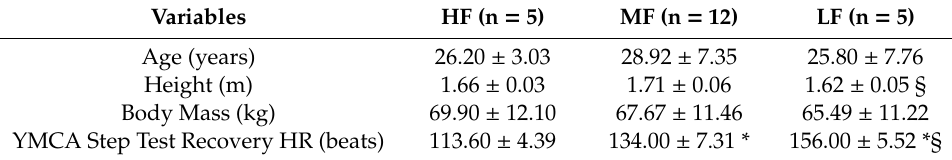
Table 2. Descriptive data (mean ± SD) for age, height, body mass, and recovery heart rate (HR) from the YMCA step test for higher fitness (HF), moderate fitness (MF), and lower fitness (LF) custody assistant